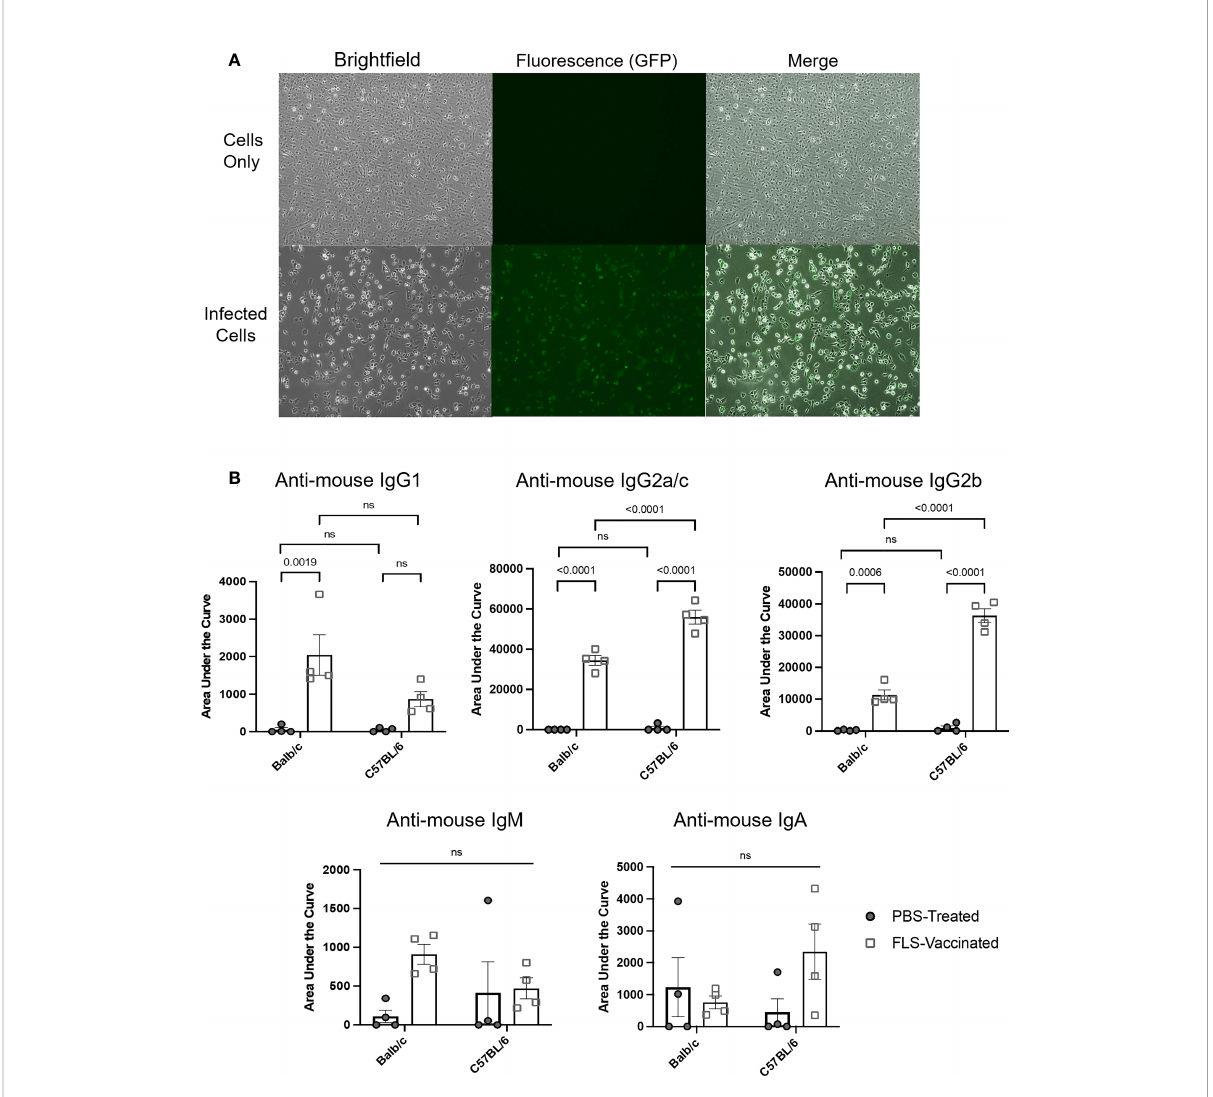
FIGURE 6 Detection of antibody responses induced by a viral-vectored vaccine platform targeting a pre-de fi ned antigen. (A) DF-1 cells were treated for 16 hours with media only or infected at a multiplicity of infection of three with a recombinant avian orthoavulavirus-1 (AOaV-1) expressing the full- length spike protein (FLS) from severe acute respiratory syndrome-coronavirus-2. Spike protein expression on target cells was assessed using an immuno fl uorescence assay following incubation of cells with a murine primary AOaV-1 ribonucleoprotein-speci fi c antibody diluted 1/2,000, and a secondary goat-anti-mouse conjugated with Alexa Fluor 488 diluted 1/1,000. Bright fi eld and fl uorescent images were captured with an inverted fl uorescent microscope at 20x magni fi cation, with identical exposures for uninfected and infected cells. Target cells were expressing spike protein based on evidence of an Alexa Fluor 488 signal. (B) Disease-free Balb/c and C57BL/6 female mice were inoculated intramuscularly with phosphate- buffered saline (PBS) or a recombinant adenovirus expressing FLS (Ad-FLS). Plasma was collected 21 days post-vaccination and analyzed for isotype- speci fi c antibodies directed against the spike protein using AOaV-1-FLS-infected DF-1 cells as the source of the target antigen. Spike protein- associated antibody binding was represented as a function of positive anti-mouse IgG1-APC, IgG2a/c-Alexa Fluor 488, IgG2b-PE-Cy7, IgM-PerCP- Cy5.5, or IgA-BV421-conjugated secondary antibody signals from target cells. Mean areas under the curves were calculated following determination of mean fl uorescence intensities for all plasma dilutions tested. These were plotted and compared to evaluate antigen-speci fi c, therapy-induced antibodies bound to antigen-expressing target cells. Statistical analysis was conducted by two-way analysis of variance. Statistical signi fi cance was de fi ned as P-values less than or equal to 0.05. ns = "not signi fi